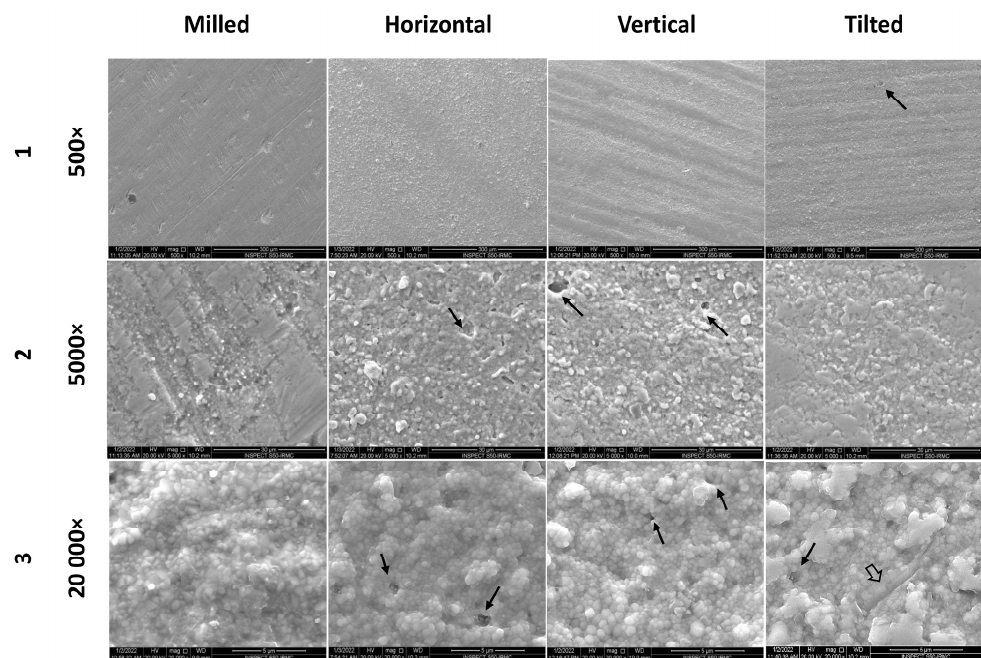
Figure 6. Surface characteristics of representative specimens from each group ( 1A – 1D ) at 500 × , ( 2A – 2D ) at 5000 × , and ( 3A – 3D ) at 20,000 × .